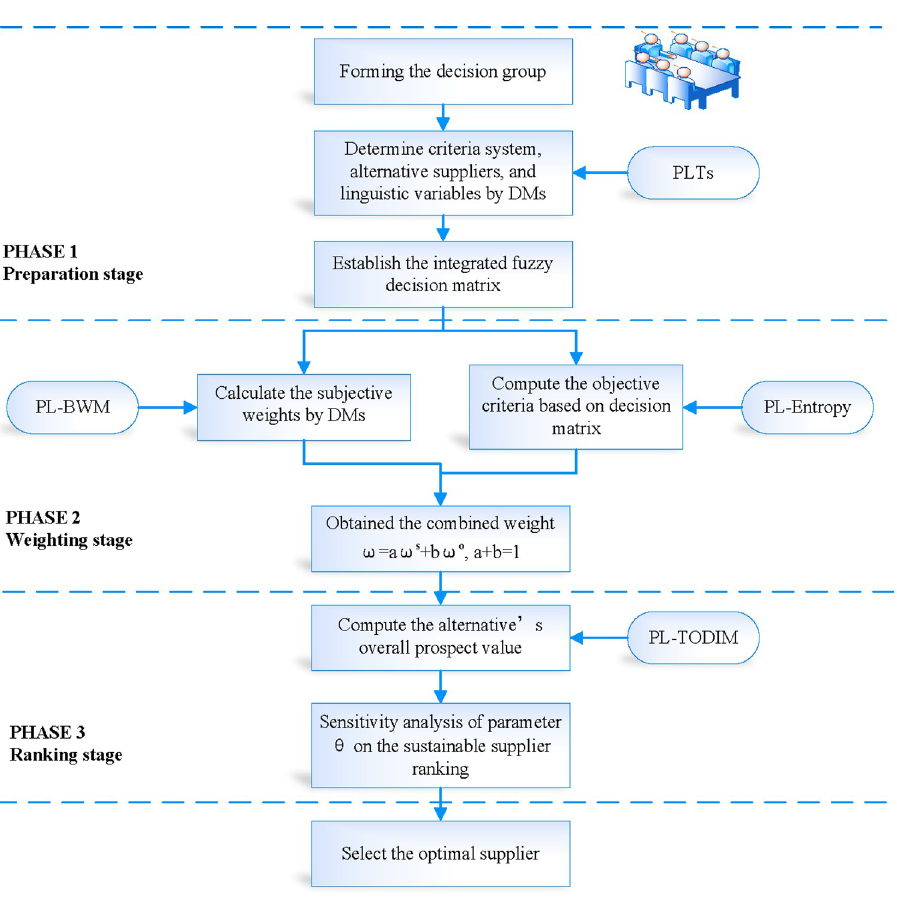
Fig 2. The conceptual framework of the MCGDM